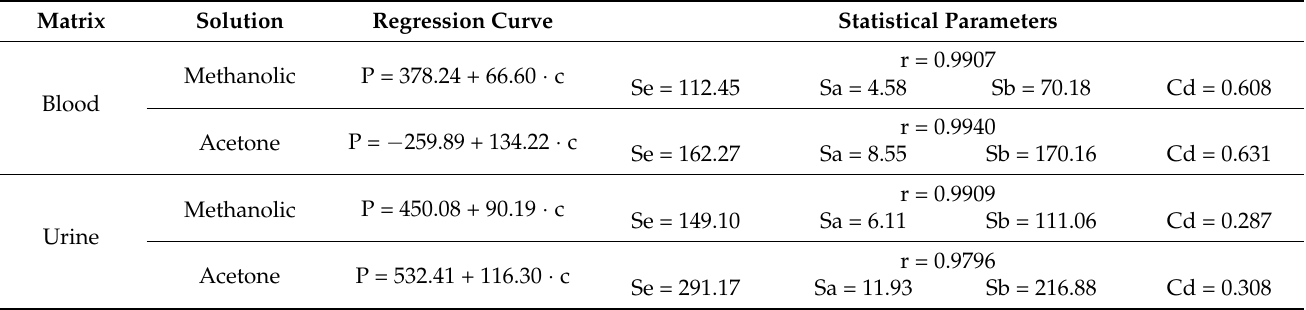
Table 3. Linearity parameters in the set range of methanol and acetone blood or urine ceftobiprole